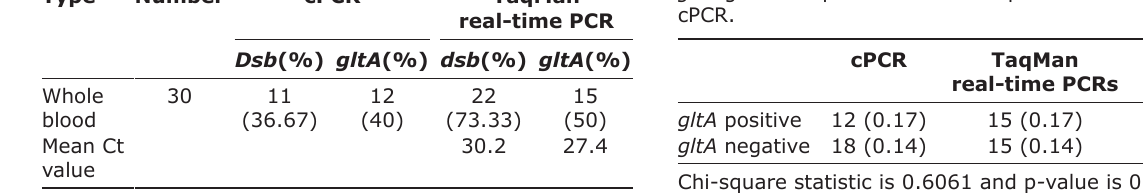
Table-4: Number of positive samples detected using cPCR and TaqMan real-time PCR. Type